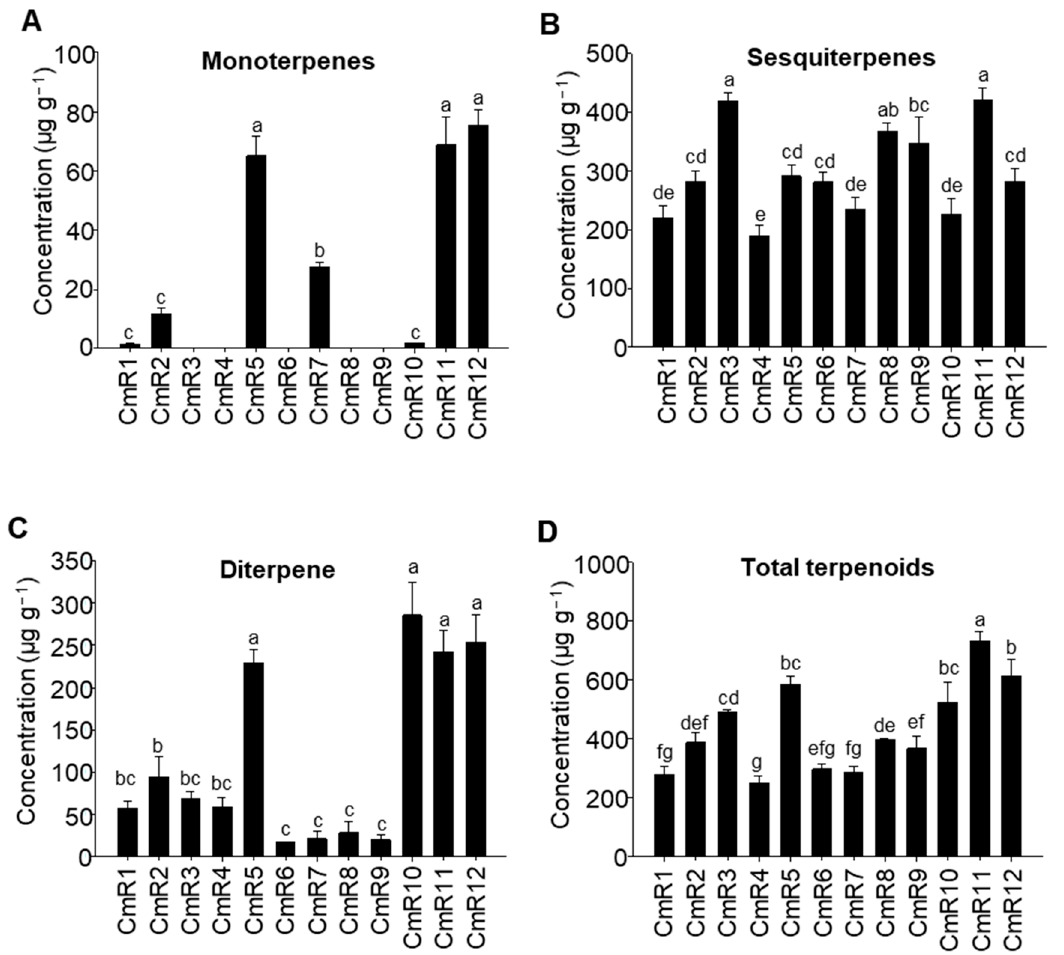
Figure 2. Concentrations of the monoterpenes ( A ), sesquiterpenes ( B ), diterpene ( C ), and total Table 1. Di ff erent letters in ( A – D ) denote statistically significant di ff erences among the means according terpenoids ( D ) in root extracts of 12 cultivars of C. morifolium. CmR1-12 refer to the cultivar codes in to ANOVA analysis ( p < Table 1. Different letters in ( A )–( D ) denote statistically significant differences among the means according to ANOVA analysis ( p < 0.05).